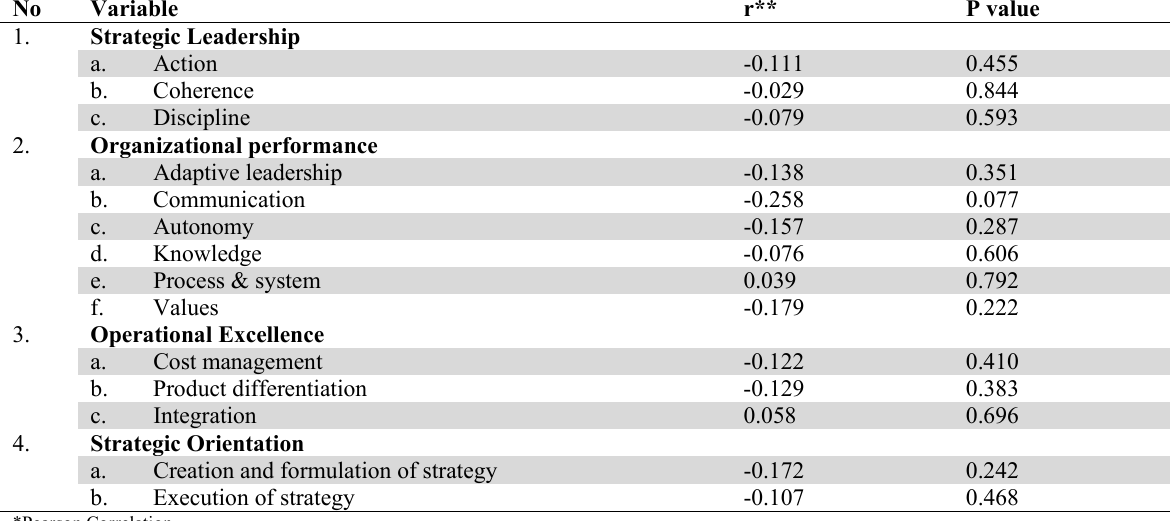
Correlation between age to strategic leadership, operational strategy, strategic orientation, organisational performance for Proton (n=48)